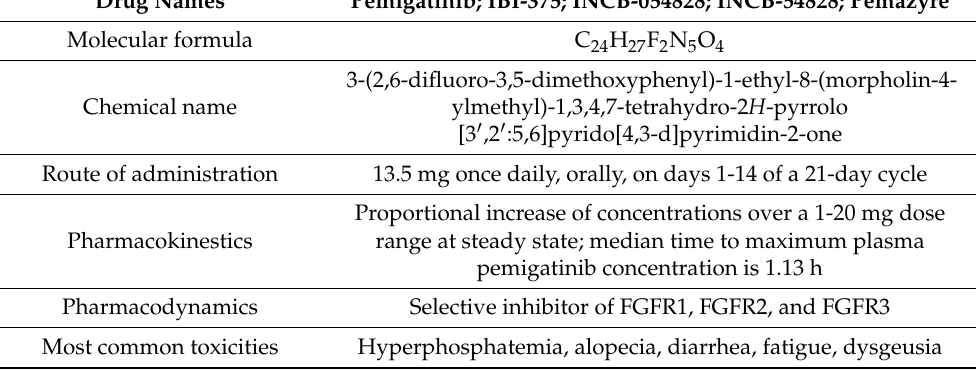
Table 1. Main characteristics of pemigatinib in terms of route of administration, pharmacokinetics and